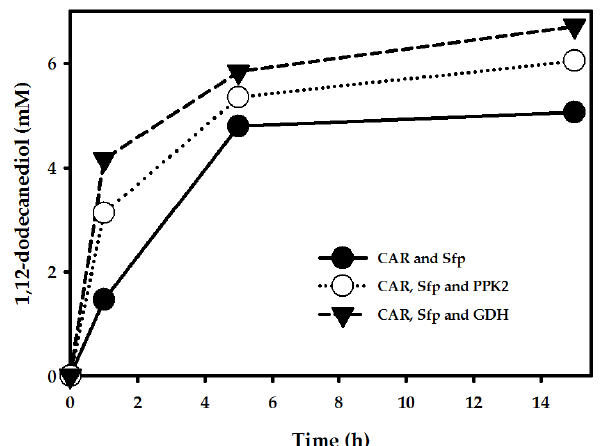
Figure 7. In vivo production of α , ω‐ diols using E. coli BW25113 ( ∆ fadD, DE3) cells expressing MmCAR and Sfp. Reaction conditions: Substrate, 7 mM biotransformed ω‐ OHDDA; Volume, 10 mL in 100 mL flask; Temp, 30 °C; Buffer, 100 mM potassium phosphate buffer (pH: 7.5) with 1% glucose ( w / v ) and 10 mM MgCl 2 ; Cell OD 600 , 30. Values were obtained by triplicate experiment with standard deviations within ≤ 10%.